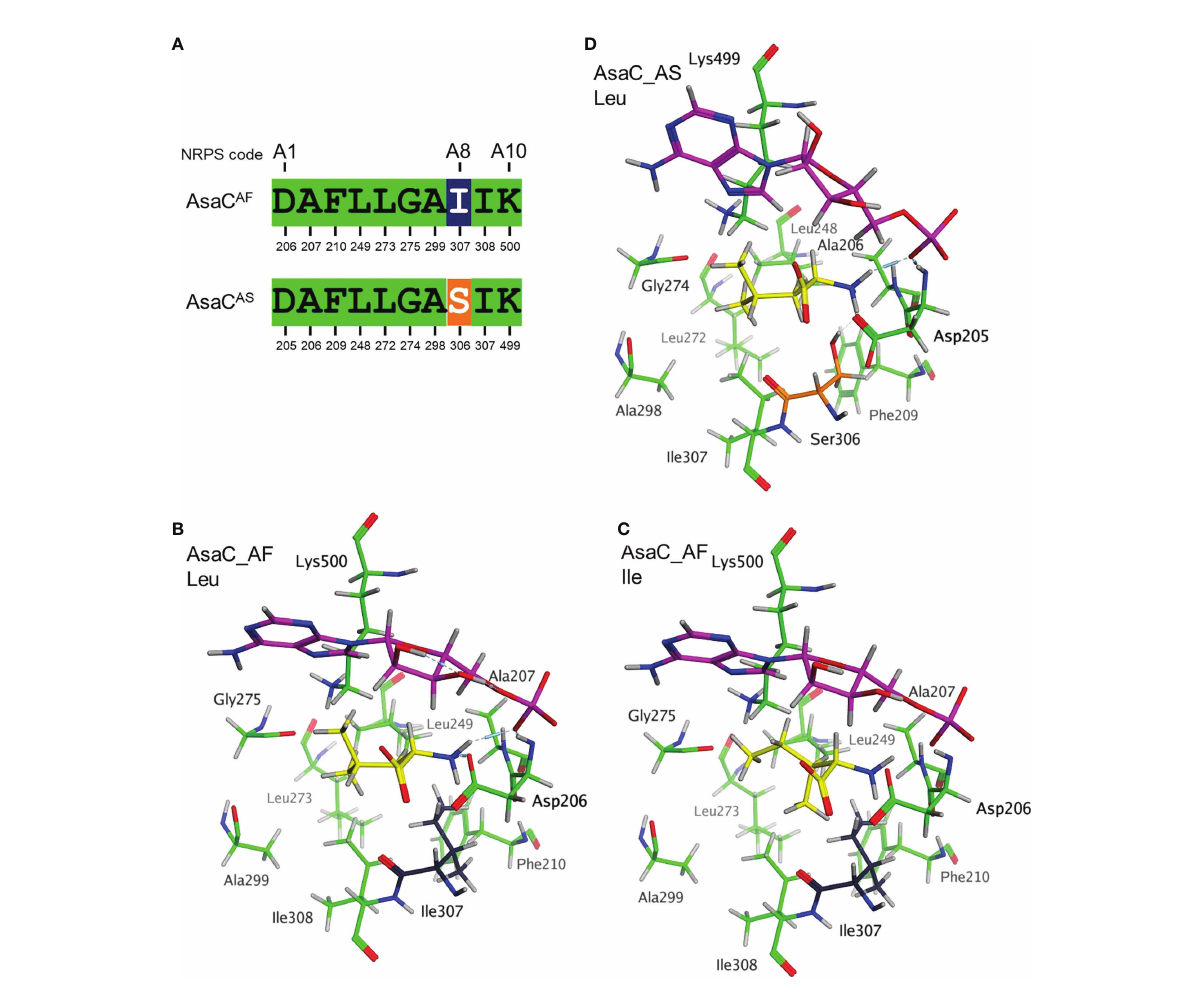
FIGURE 5 The nonribosomal codes of AsaC in Aspergillus section Flavi and section Circumdati differ by only one residue. (A) Alignment of the 10 key amino acid residues in the nonribosomal code using GrsA-PheA as a reference. AsaC_AF represents the code from A. fl avus as well as AsaC from all Aspergillus section Flavi species sequenced to date (see Figure 1). AsaC_AS represents the code from A. sclerotiorum and AsaC from all Aspergillus section Circumdati species sequenced to date (see Figure 1). Stick rendering model of the 10 key amino acids in AsaC_AF (B, C) and AsaC_AS (D) enzymes using the PheA crystal structure (pdb 1AMU) as a template. Key amino acid colors are consistent with the alignment in panel (A) . Complexed amino acids leucine (B, D) or isoleucine (C) are colored yellow, and cAMP (in magenta) is orientated similarly near the top of each